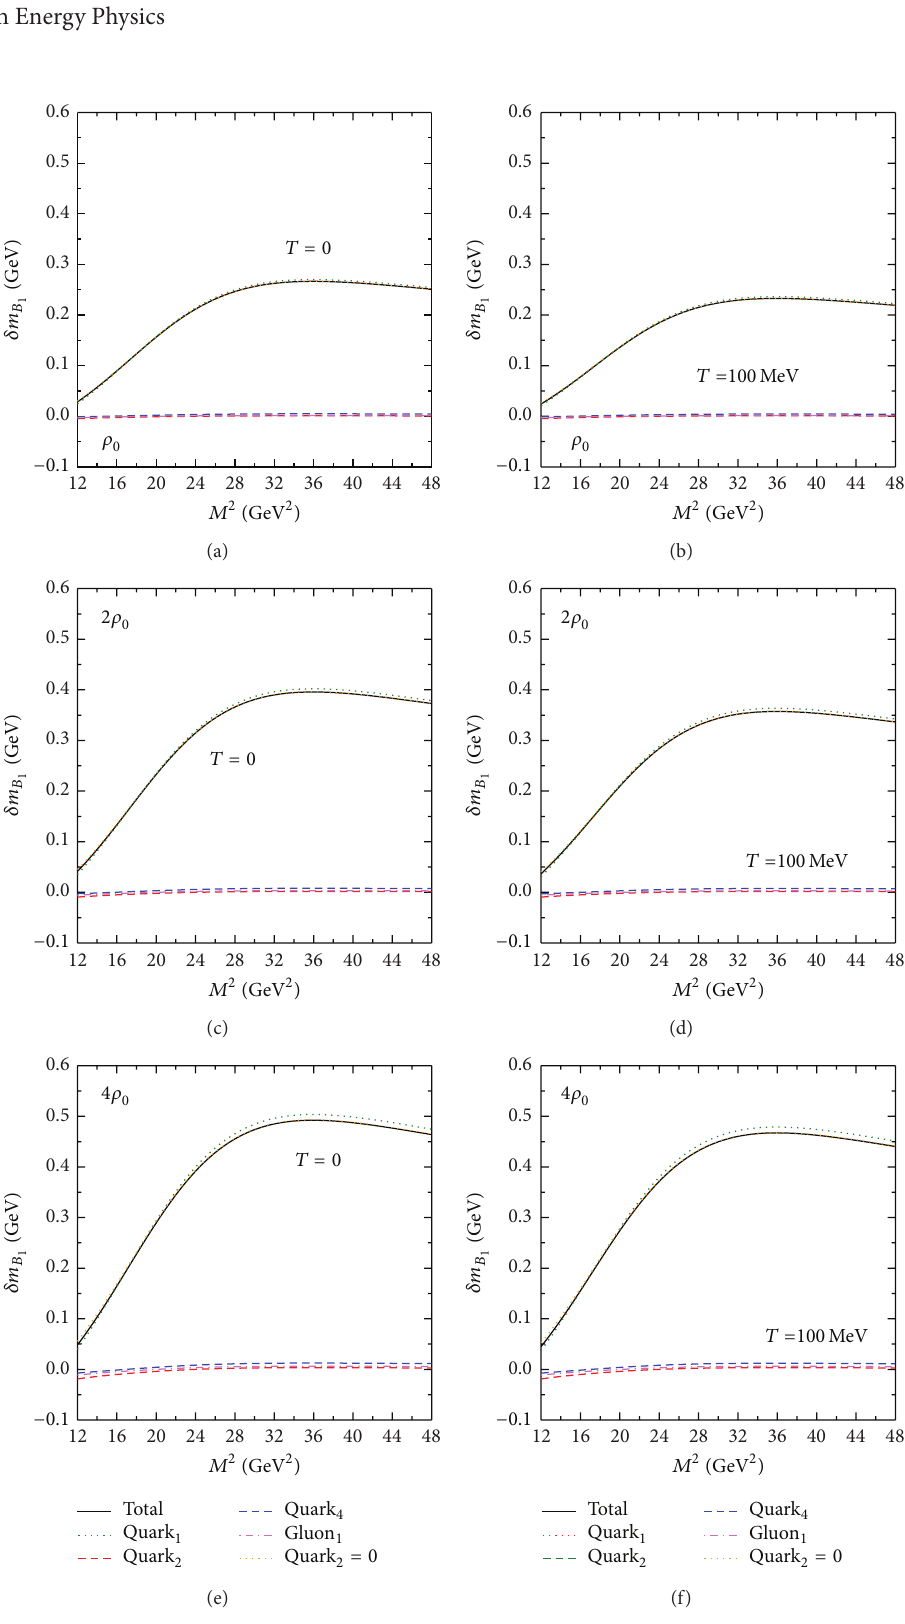
Figure 11: (Color online) Figure shows the contribution of individual condensates to the mass shift of axial-vector mesons 𝐵 1 as a function of the squared Borel mass parameter, 𝑀 2 . The subplots (a), (c), and (e) show the results at temperature 𝑇 = 0, whereas the subplots (b), (d), and (f) are plotted for temperature 𝑇 = 100 MeV. We have shown the results at baryon densities 𝜌 0 , 2𝜌 0 , and 4𝜌 0